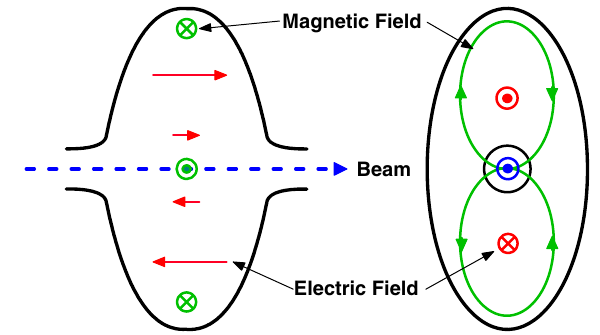
FIG. 1. Field diagram of the deflecting mode in a TM-type design.